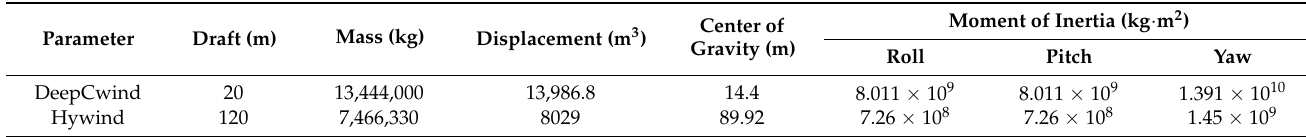
Figure 10. Schematic of the semi-submerged platform and Spar platform. Table 7. Parameters of the semi-submersible platform and Spar platform.